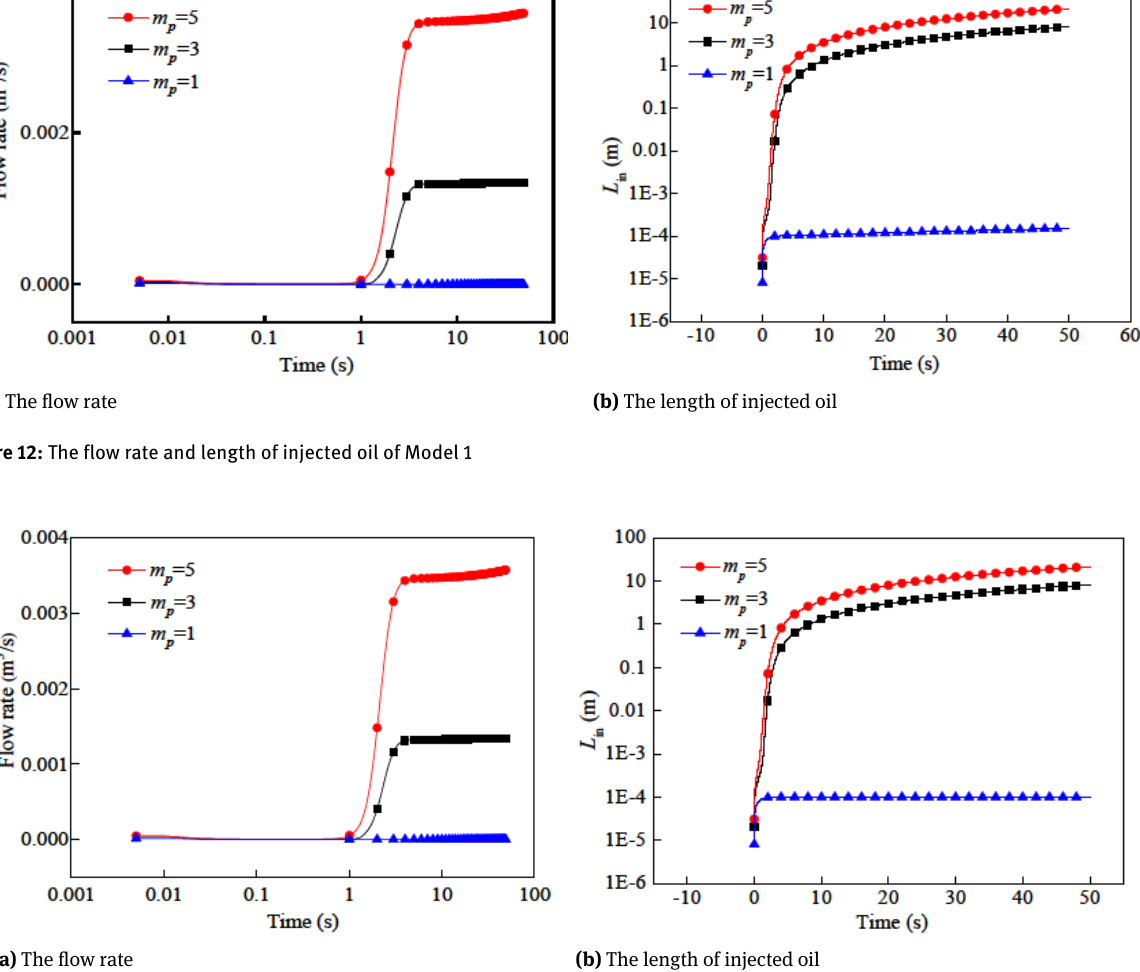
indicates that the pipeline restarts more easily. In